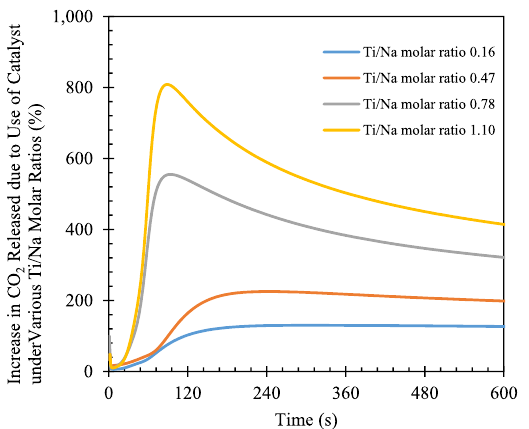
Figure 3. Effect of Ti/Na molar ratio on NaHCO 3 decomposition or CO 2 desorption [initial NaHCO 3 concentration: 0.238 mol/L; stirring rate: 600 rpm; reaction temperature: 65 °C; N 2 flow rate: 500 mL/min].